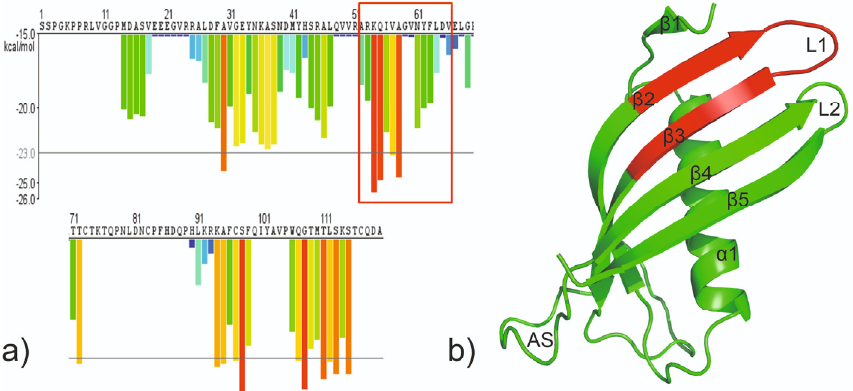
Figure 1. ( a ) The 3D profile prediction of fibrillizing segments in HCC sequence. The predicted lowest energy template interactions according to ROSETTADESIGN energy calculation are plotted at the initial residue of each hexapeptide. Red and orange bars represent sequences of the hexapeptides which have tendency to form fibrils. Yellow, green, and blue bars represent sequences of the hexapeptides that are predicted not to form fibrils [25]. ( b ) The crystal structure of the monomeric mutant V57N (PDB: 3XN0; [18]) with marked fragments fulfilling potential conditions of steric zipper; red: Ala 52 − Asp 65 .